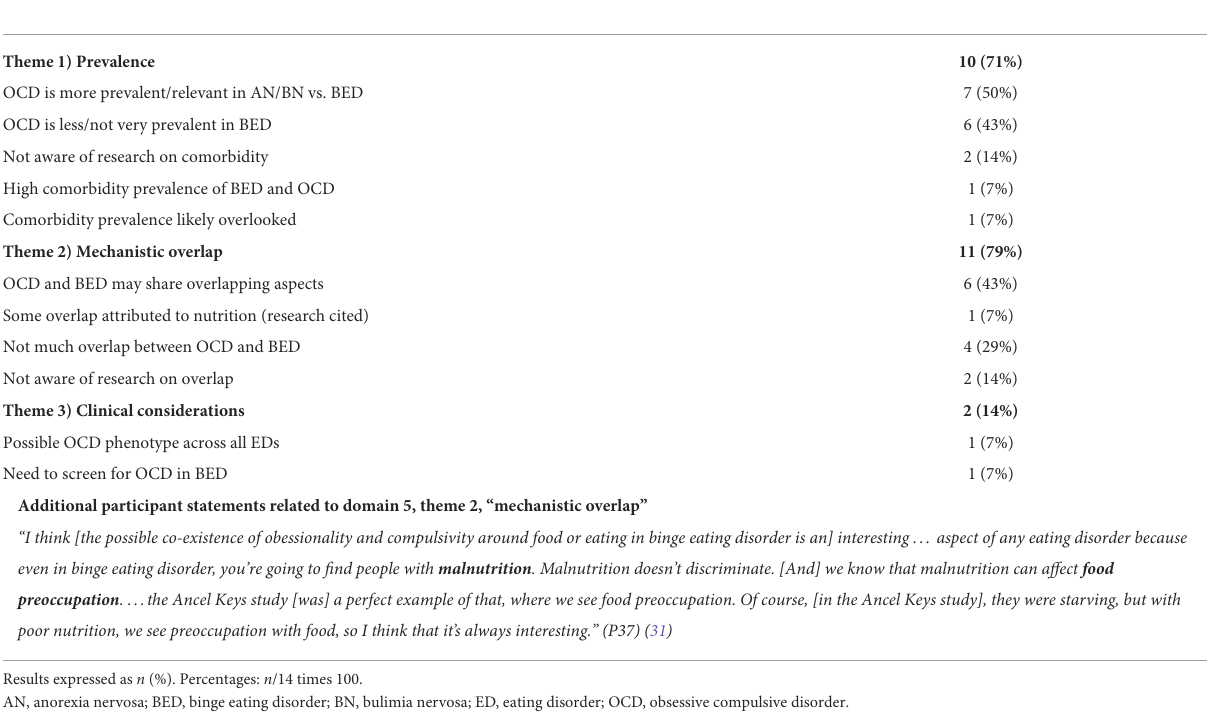
TABLE 8 Participant statements relating to domain 5,